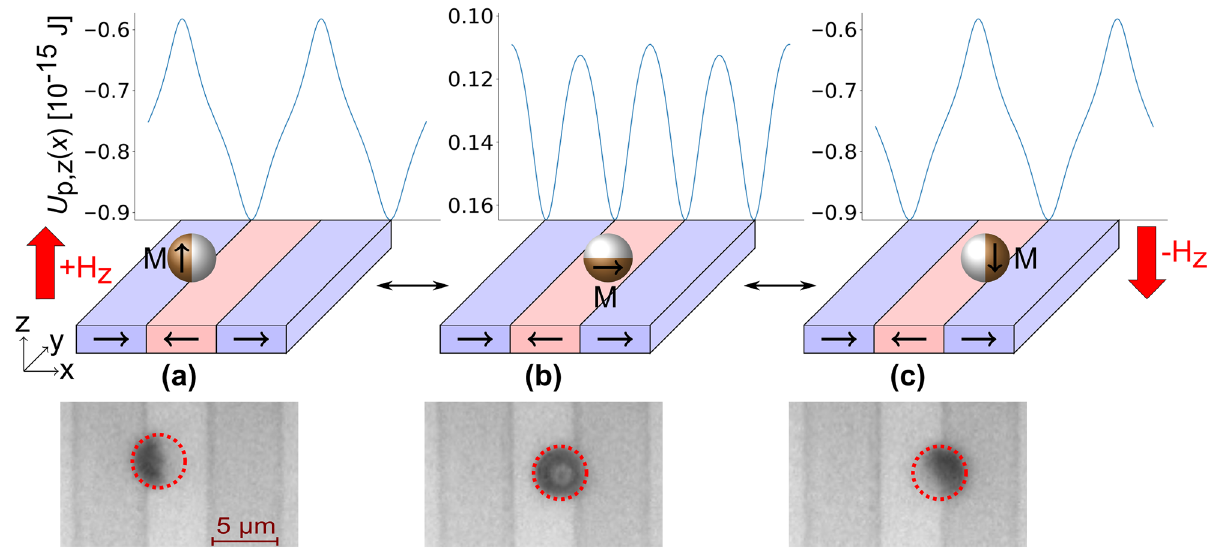
Figure 2. Position and spatial orientation of a magnetic Janus particle (MJP) with an in-plane exchange-bias cap in the magnetic stray field landscape of a magnetically patterned EB substrate with additionally applied field pointing into the layer plane ( a ), out of the layer plane ( c ), and with no applied external field ( b ). The direction of magnetization for the magnetic domains and the MJPs is indicated by arrows. The magnetic states of the MJP and its positions and orientations with respect to the underlying domain pattern with and without applied external magnetic field is sketched in the middle panels of ( a )–( c ). Corresponding microscopy images are shown in the lowermost panels. The calculated potential energy landscapes for the three displayed situations U p,z ( x ) are depicted as solid blue lines in the uppermost